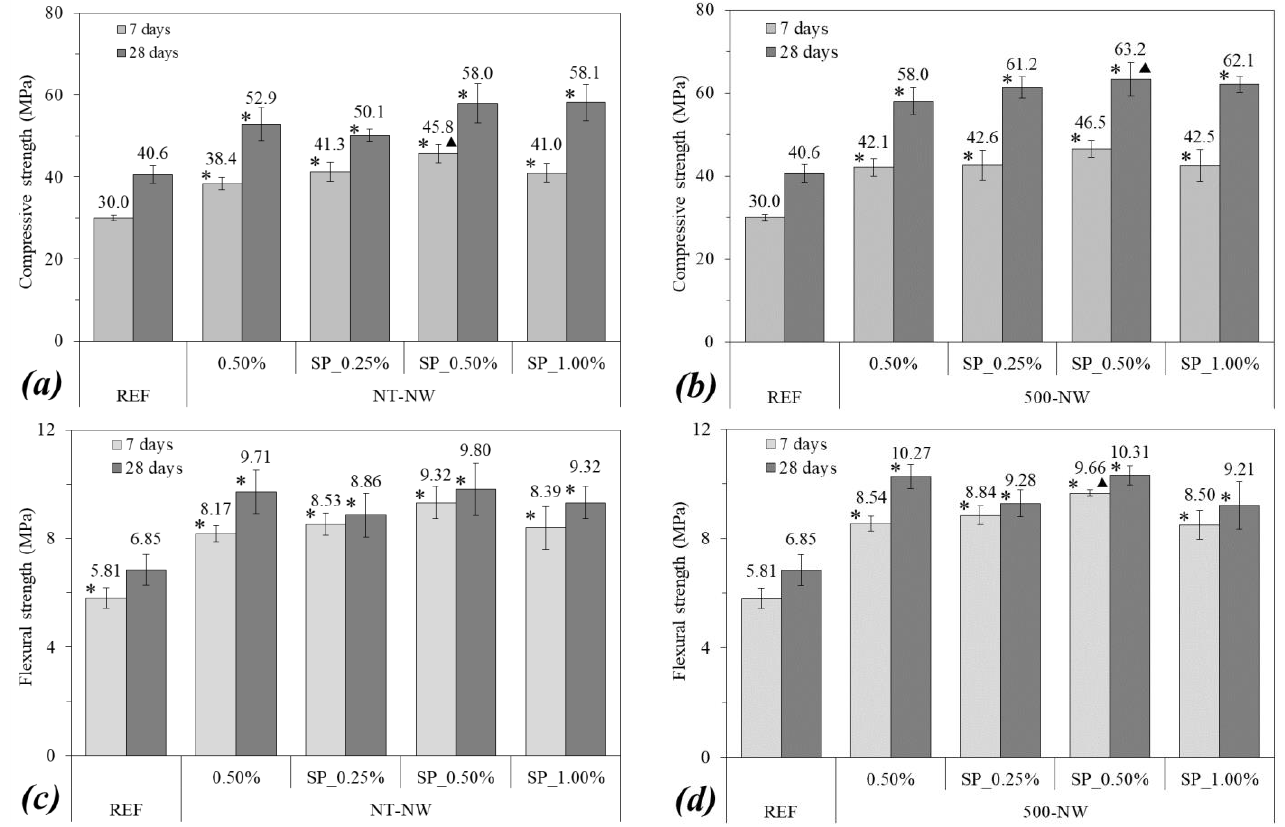
Figure 6. ( a , b ) Compressive strength; ( c , d ) flexural strength of the composites. Error bars correspond to ±1 standard deviation. Stars indicate significant differences in comparison with REF and triangles indicate significant differences between the samples with and without SP.